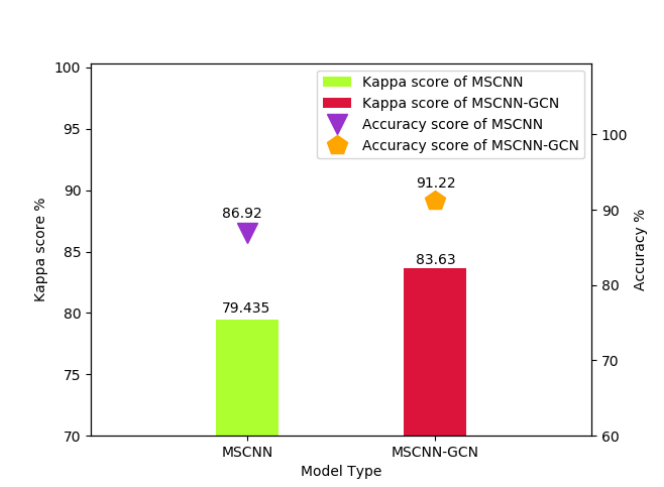
Figure 7. Comparison between MSCNN and